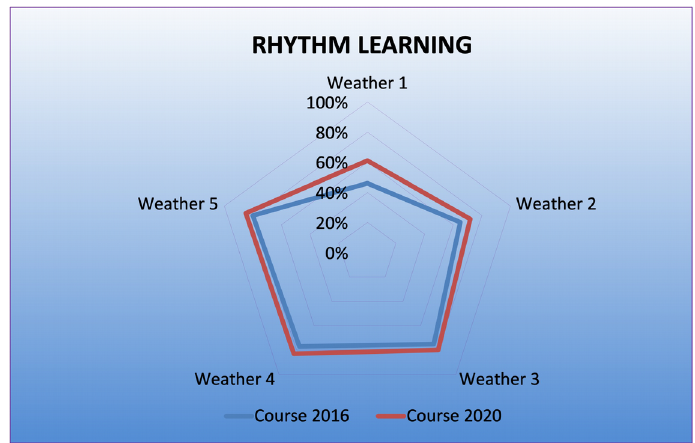
Figure 3. Comparative learning rate period 2016 and